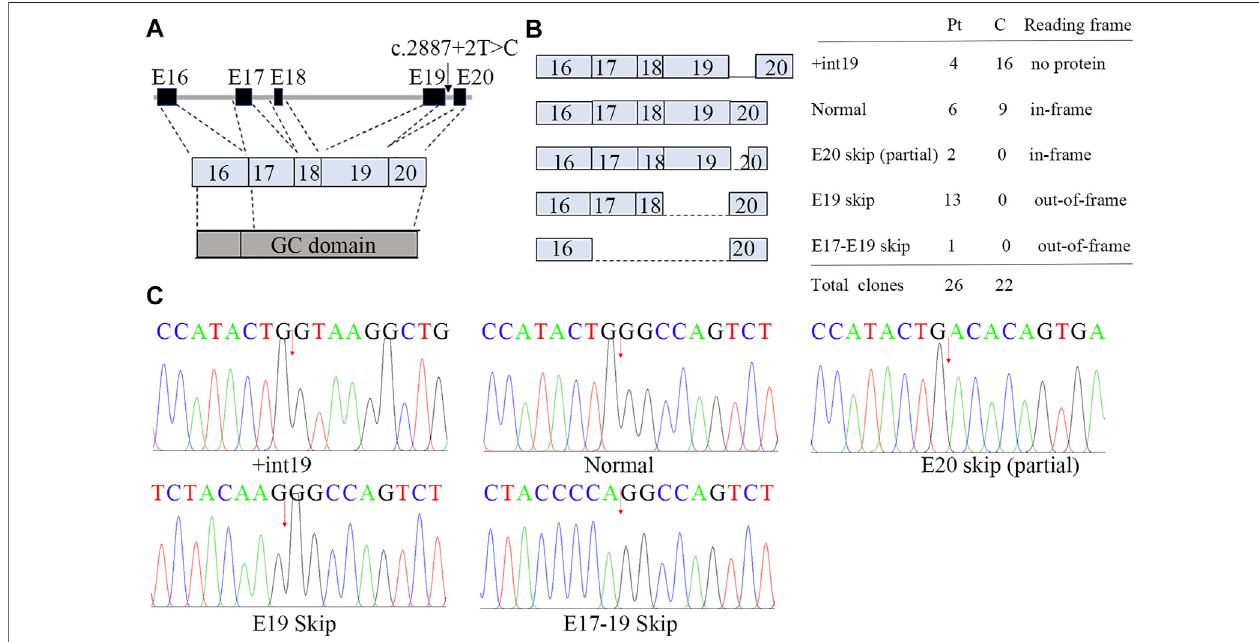
FIGURE 4 | Aberrant splicing of c.2887+2T > C. (A) Genomic architecture of NPR2 gene through exons 16 to 20. (B) Subcloning of the RT-PCR product demonstrated multiple forms of aberrant splicing. The table shows the number of clones. (C) cDNA sequencing of breakpoint in NPR2 . The possible breakpoints are indicated with